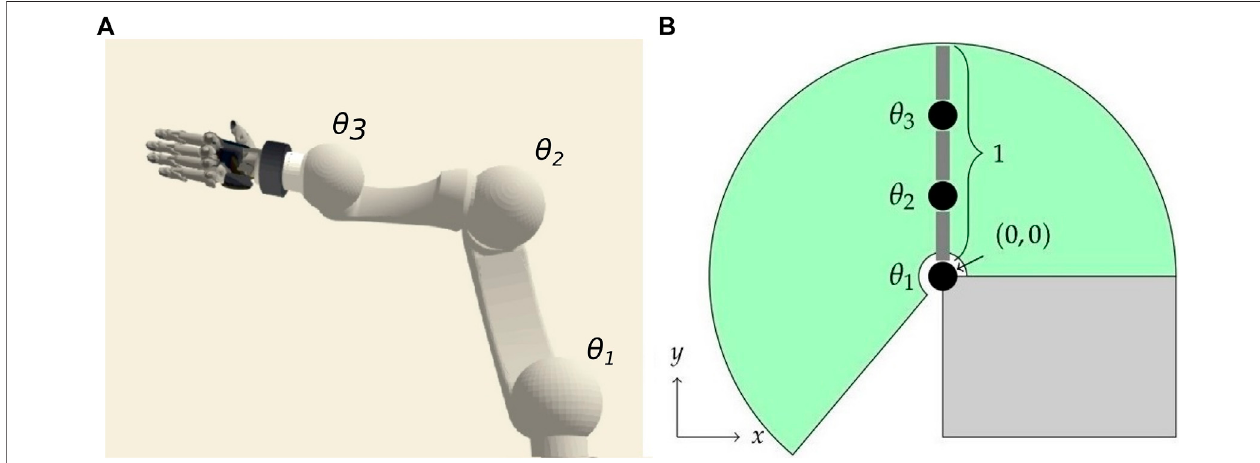
FIGURE 1 | Neuron activity is analyzed in neural networks trained for target reaching of multi-joint robotic manipulators utilizing end-to-end deep Q-Learning. We trainthenetworkinasimpli fi edenvironmentofarobotwith2 – 4controllablejointsoperatinginaverticalplane[ (A) ,initialcon fi gurationwithjoints θ i ].Thetransferabilitytoa robotic simulation (B) has been demonstrated with movements restricted to a vertical